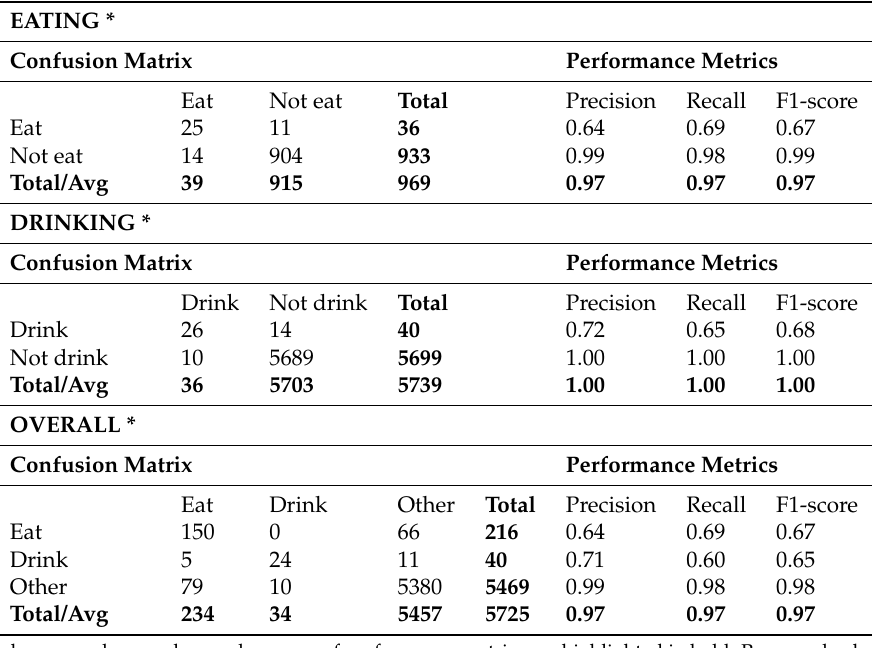
Table 7. All day acquisition recognition performance.